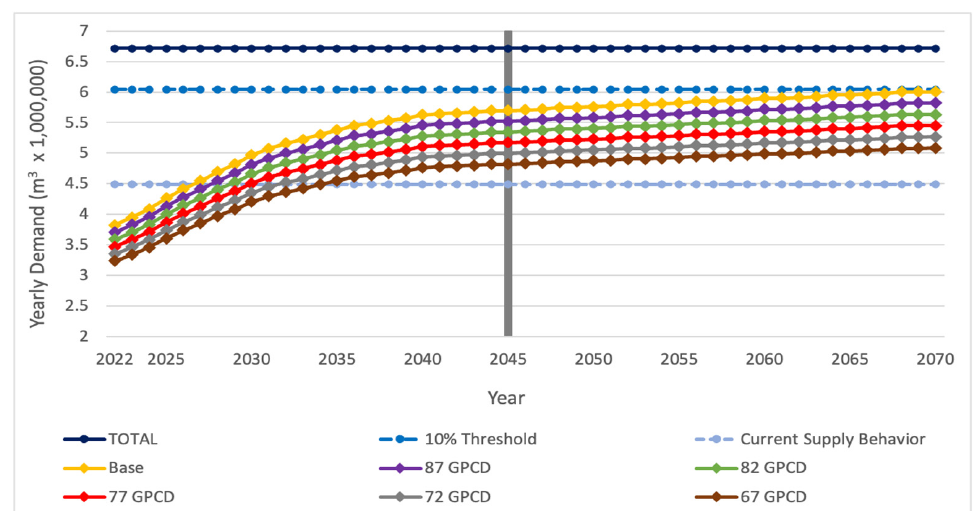
Figure 6. Reductions to Residential Indoor Consumption.